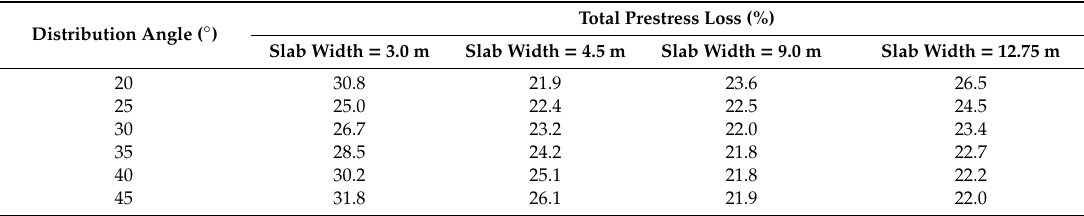
Table 13. The total prestress loss of steel strands